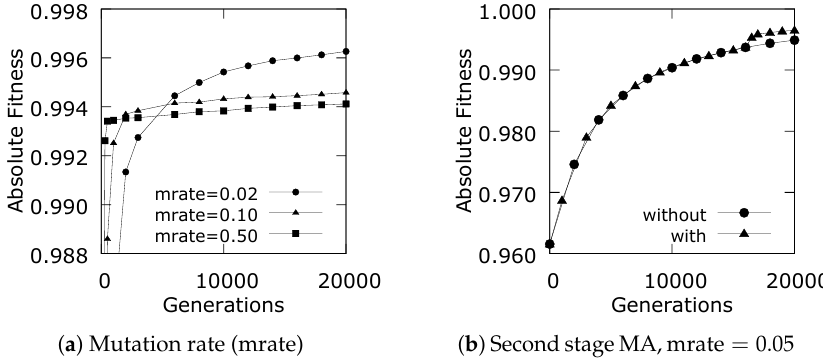
Figure 5. Evolutionary paths, torus phantom.